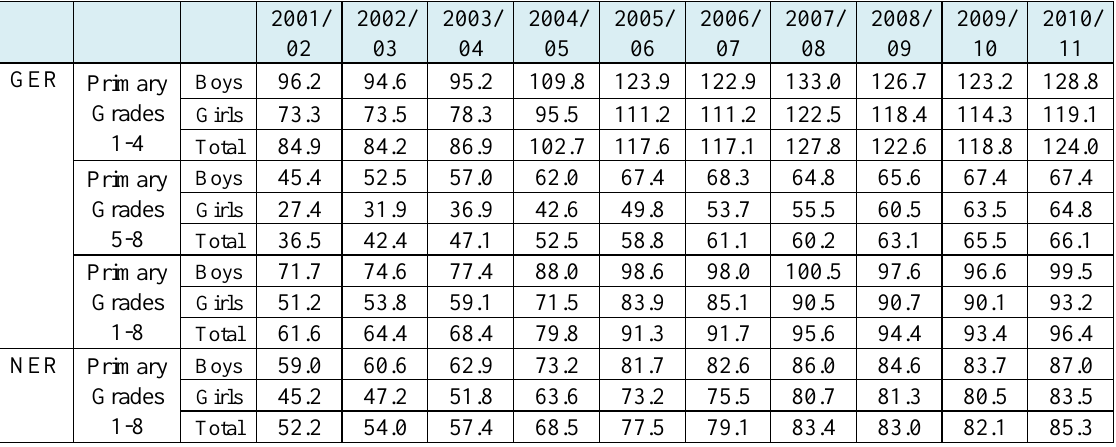
Table 4-4: Primary Gross and Net Enrollment Rates (2001/02 - 2010/11) (%)